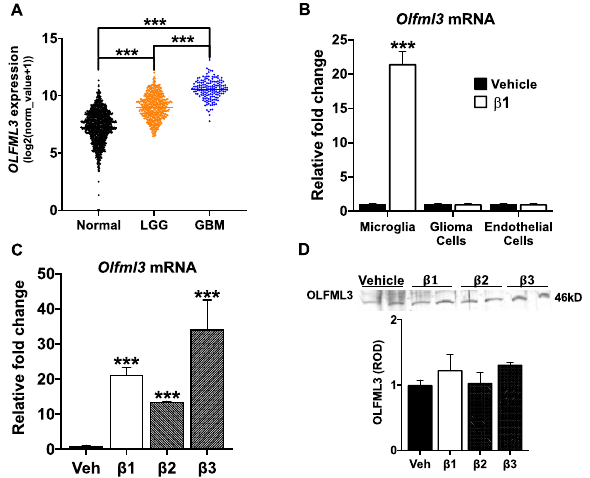
Figure 1. OLFML3 is increased in GBM and is regulated by TGF β in microglia. ( A ) OLFML3 mRNA is increased in low-grade glioma (LGG; n = 529) and glioblastoma (GBM; n = 166) relative to normal brain (Normal; n = 1141) in TCGA patient datasets. ( B ) Exposure to β 1 (5 ng/mL; 48 h) increased Olfml3 mRNA 20-fold in a microglial cell line (N9) but did not affect mRNA expression in a mouse glioma cell line (GL261) or primary mouse brain endothelial cells. Fold was calculated via ∆∆ Ct and normalized to GAPDH; *** p < 0.001. ( C ) Exposure to each TGF β isoform increased Olfml3 mRNA (5 ng/mL; 48 h); *** p < 0.001. ( D ) Representative immunoblot for OLFML3 protein in N9 cell lysate following exposure to vehicle (Veh) and TGF β isoforms (5 ng/mL; 48 h). The optical density of OLFML3 protein in cell lysates was measured and normalized to the Ponceau stain. Relative optical densities (ROD) were expressed relative to vehicle-treated cells. No differences were measured between groups ( p = 0.17). Comparisons based on one-way ANOVA with Tukey’s Multiple Comparison Test. Bars represent group mean with standard error of the mean (SEM); data represent one of three independent